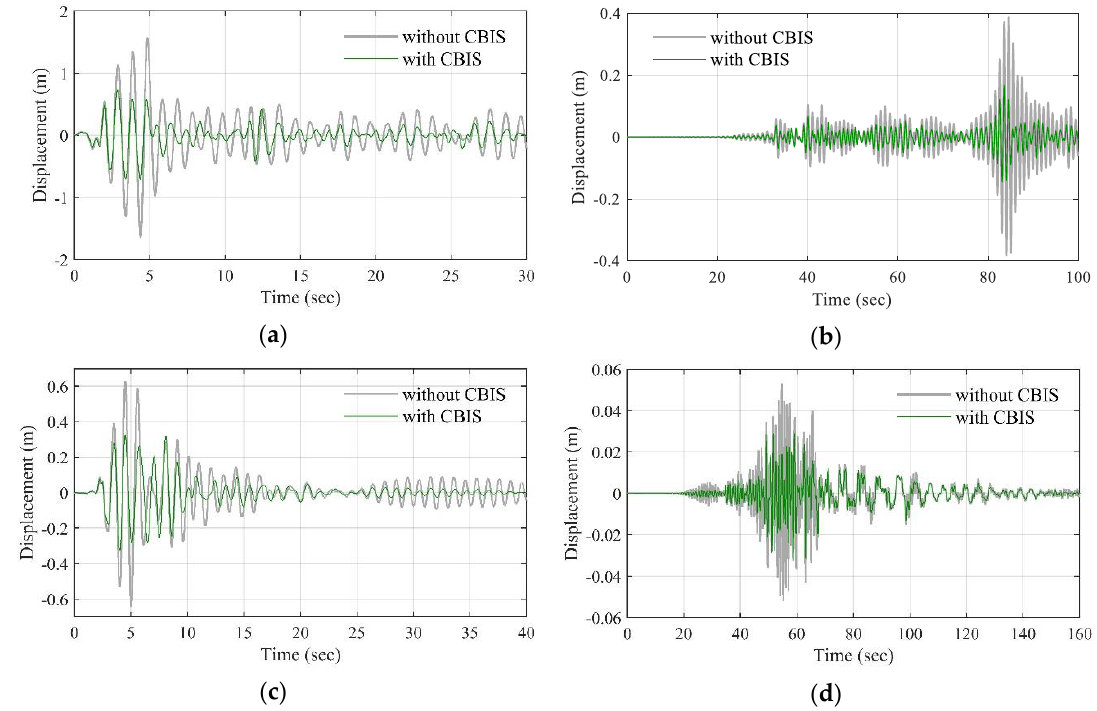
Figure 11. Displacement response time histories for two test frame roofs during ( a ) the El Centro wave, ( b ) the Tohoku wave recorded by Tohoku University, ( c ) the Kobe record and ( d ) the Chi–chi record.